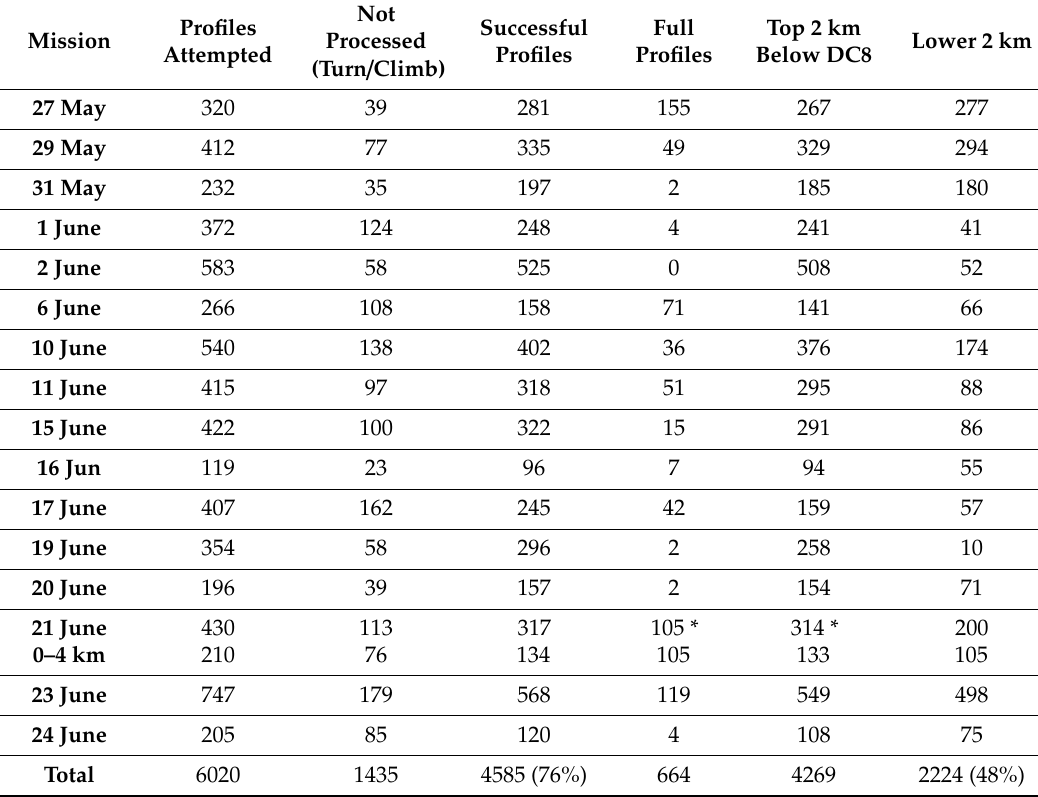
Table 6. Outcome of Attempted DAWN Profiles during